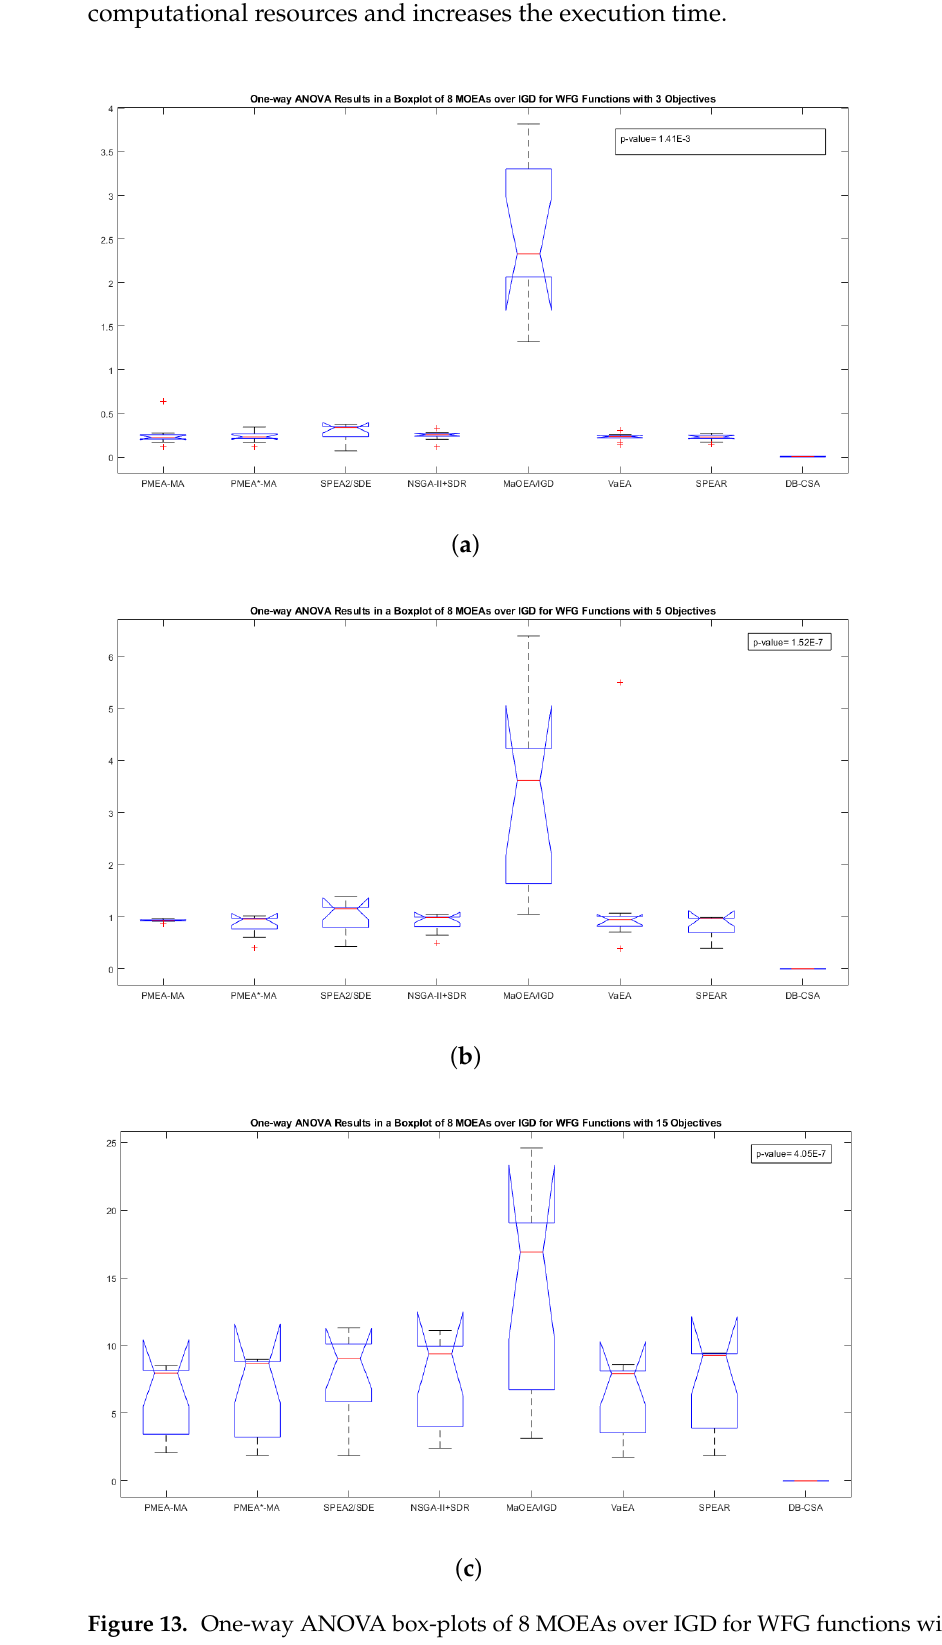
Figure 13. One-way ANOVA box-plots of 8 MOEAs over IGD for WFG functions with ( a ) 3, ( b ) 5 and ( c ) 15